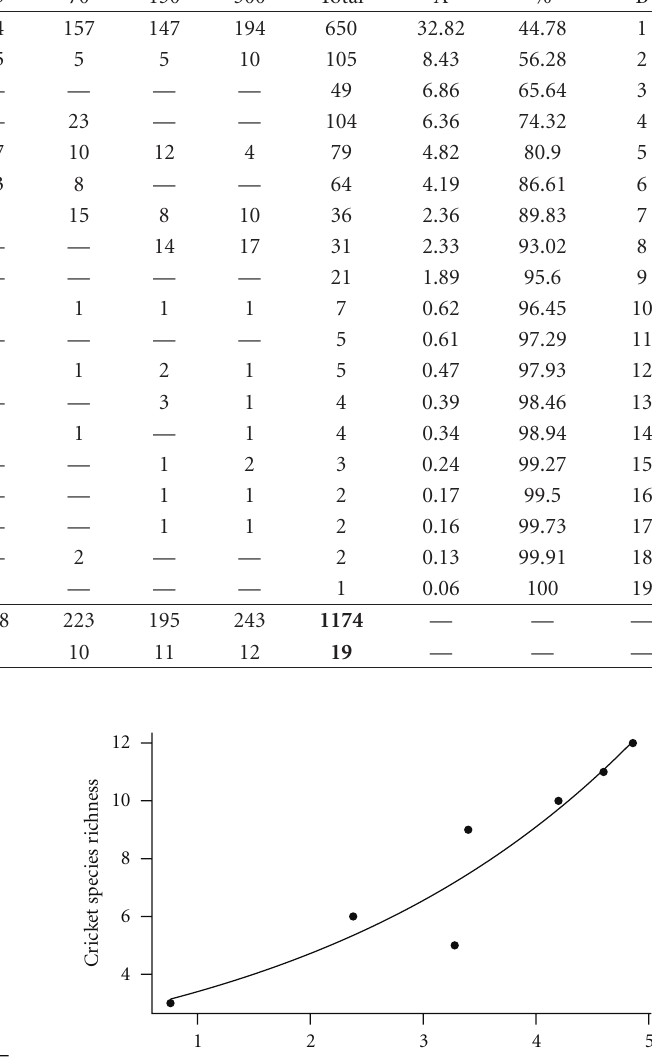
Table 2: Cricket taxa, number of individuals per forest patch, and taxa contribution to species composition groups forming in SIMPER analysis (taxon alone (A), percent value (%), and taxon order (B)). Taxa were ordered according to contribution (B). Taxa not assigned to described species or genus received number codes. All unidentified crickets belong to taxa that had not been previously collected and are therefore new to science. Taxons